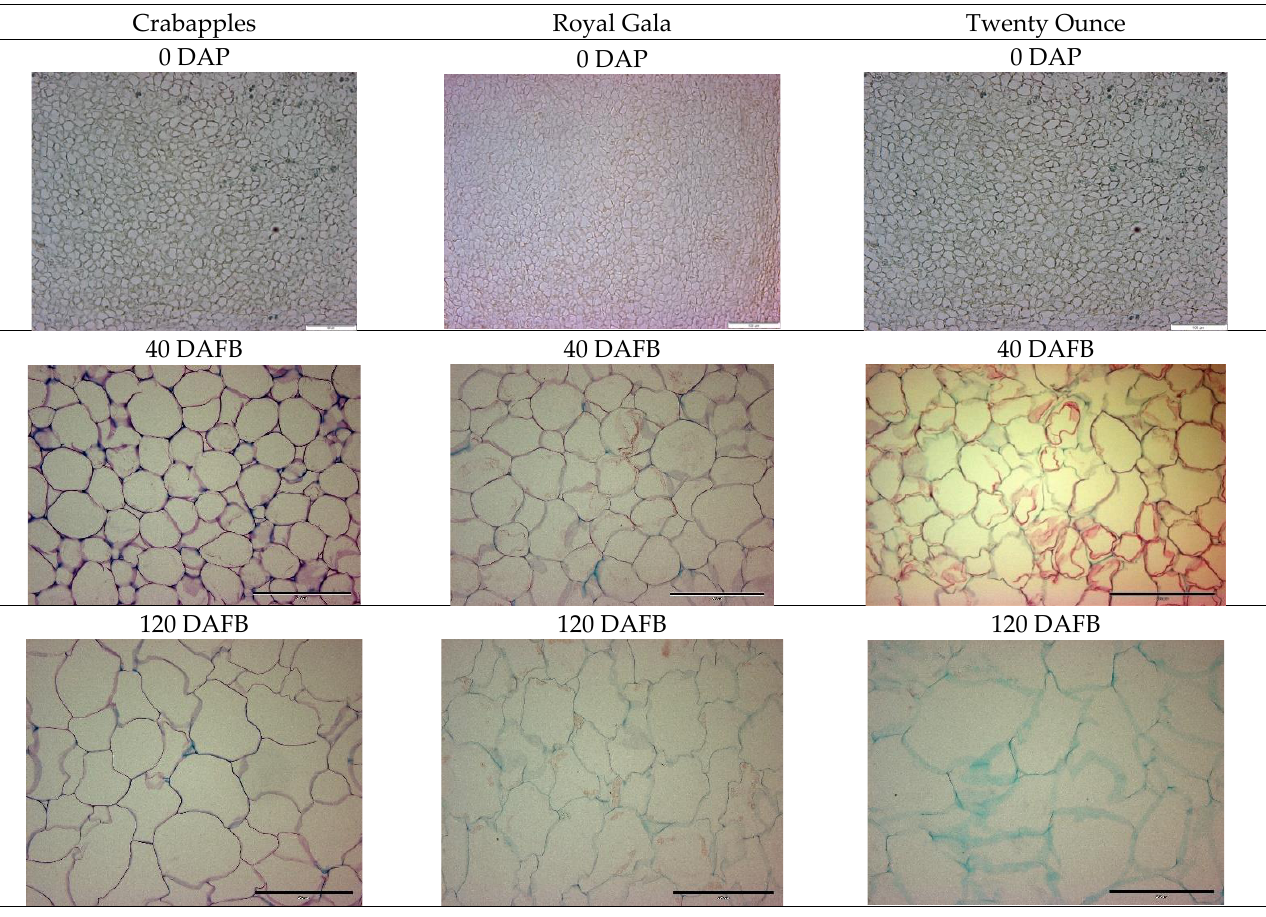
Figure 4. Microscopy images of three cultivars showing a distinct cell size increment amongst the cultivars. Scale bars represent 500 µm.